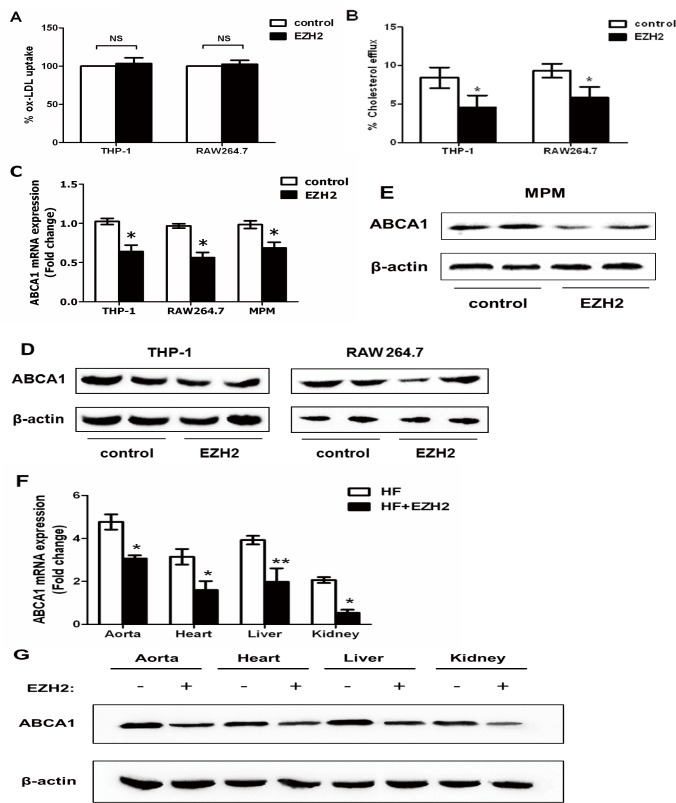
Effects of EZH2 on cholesterol efflux and ABCA1 expression.A, DiI-oxLDL (1 μg/ml) was added to THP-1/RAW264.7 macrophages infected with LV-mock or LV-EZH2 vectors. After incubation for 24 h, the uptake was analyzed by flow cytometry. The control values were set to 100%, and then uptake data were calculated as the percentage of ox-LDL uptake vs. the control. B, Cholesterol efflux assay was performed using liquid scintillation counting assays as described in Methods. Cholesterol efflux of RAW264.7 macrophages were preloaded with [3H] cholesterol-oxLDL. C, EZH2 down-regulated ABCA1 mRNA in THP-1/RAW264.7 macrophages and mouse peritoneal macrophages (MPM). ABCA1 mRNA was quantified in THP-1 and RAW264.7 infected with LV-mock or LV-EZH2 vectors for 24 h or in MPM harvested from the peritoneal cavity of apoE−/− mice 3 d after intraperitoneal injection with 2 ml thioglycollate. D, EZH2 down-regulated ABCA1 protein in both THP-1 and RAW264.7 macrophages. E, EZH2 downregulated ABCA1 protein in MPM harvested from the peritoneal cavity of apoE−/− mice 3 d after intraperitoneal injection with 2 ml thioglycollate. Representative immunoblots show the effect of EZH2 on ABCA1 expression. Mean ± S.D., one-way ANOVA, *: P<0.05 and **: P<0.01 vs. control. F, EZH2 down-regulated ABCA1 mRNA in aorta, heart, liver and kidney of apoE−/− mice. RNA from the indicated organs was isolated from apoE−/− mice injected with LV-mock (n = 5, solid bars) or LV- EZH2 (n = 5, open bars). Mean ± S.D., one-way ANOVA, *: P<0.05 vs. HF+mock group. G, EZH2 downregulated ABCA1 protein in aorta, heart, liver and kidney of apoE−/− mice. Representative immunoblots show the effect of EZH2 on ABCA1 expression. Proteins from the indicated organs were isolated from apoE−/− mice treated with LV-mock or LV-EZH2 (n = 5).